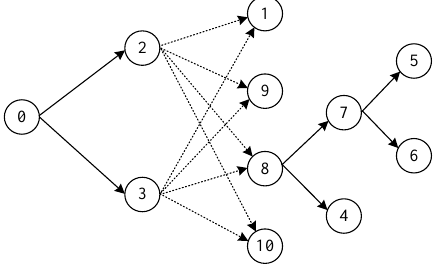
Figure 1. An example of the disassembly precedence diagram for a product.